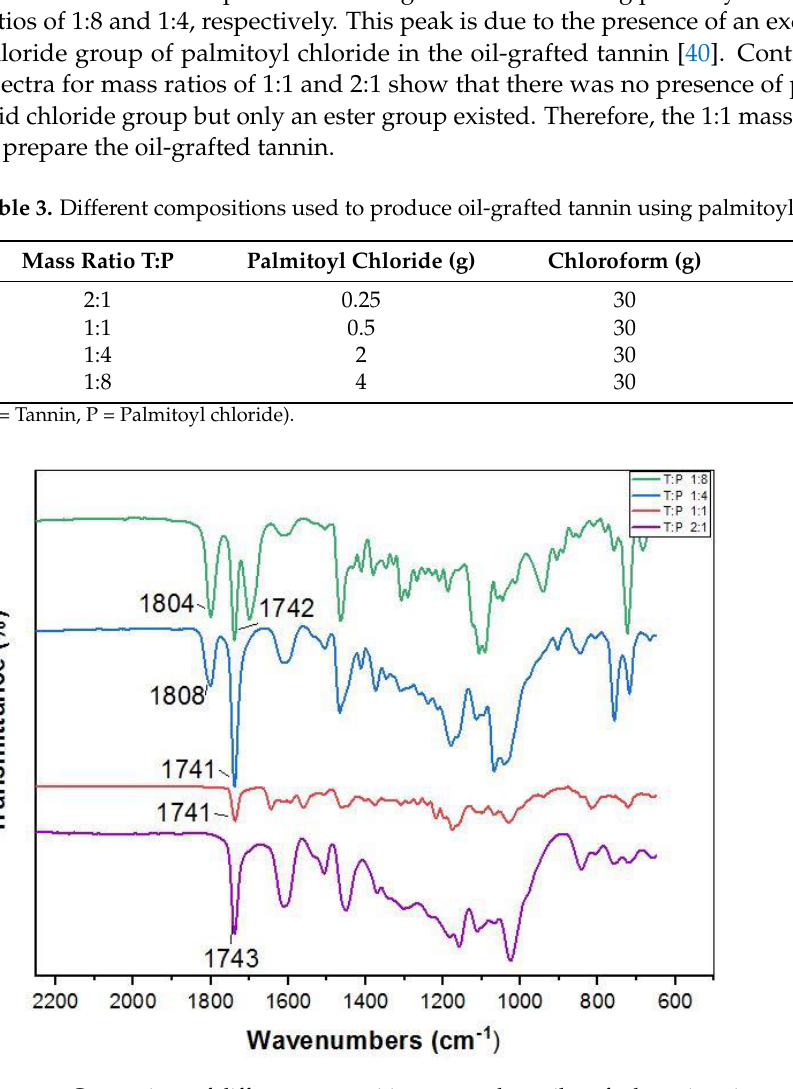
Figure 2. Comparison of different compositions to produce oil-grafted tannin using palmitoyl chloride.